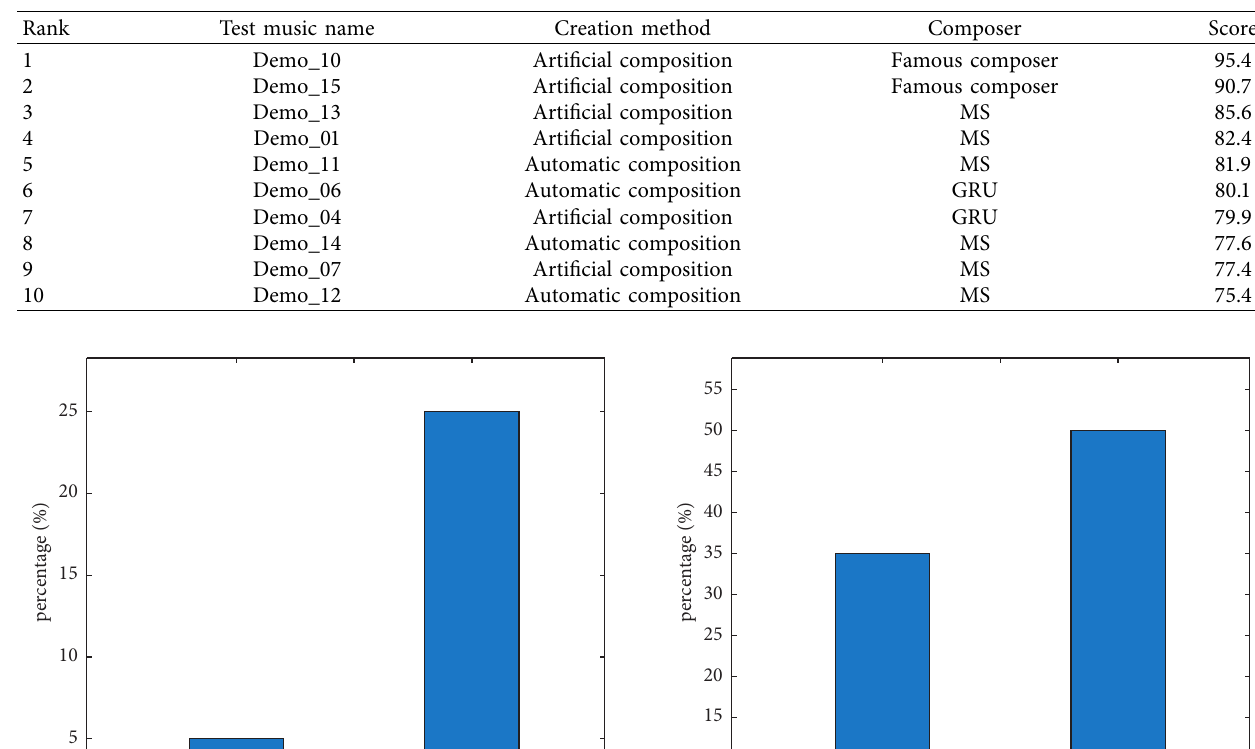
Figure 5: Percentage with a score of 4 or more. Table 3: Top ten evaluation rankings for offline audition.